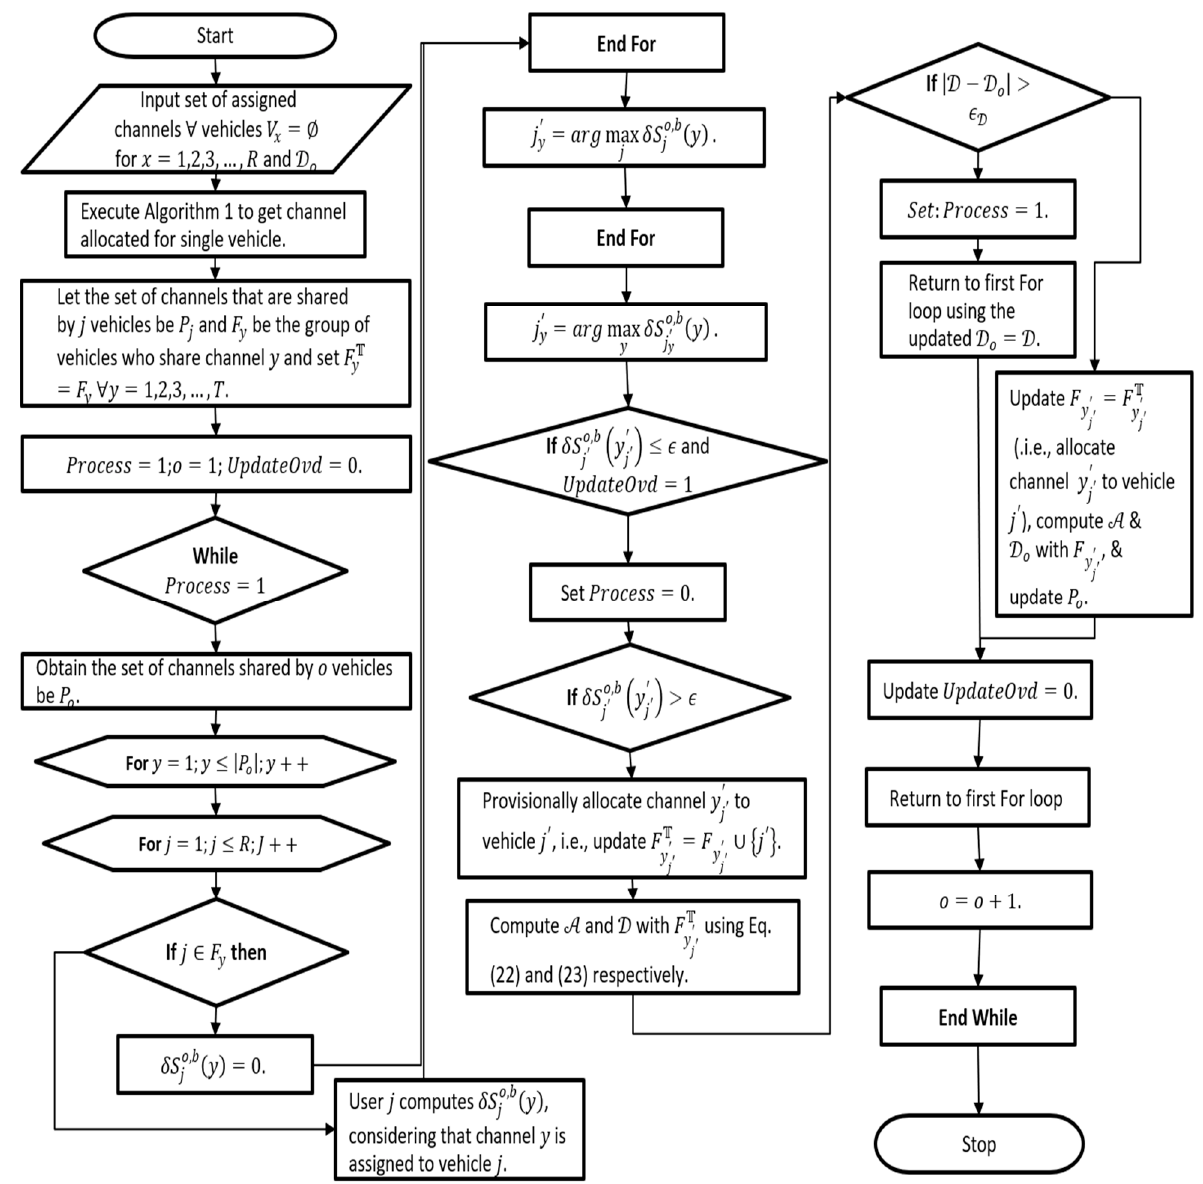
Figure 4. Flow diagram of proposed channel shared allocation.